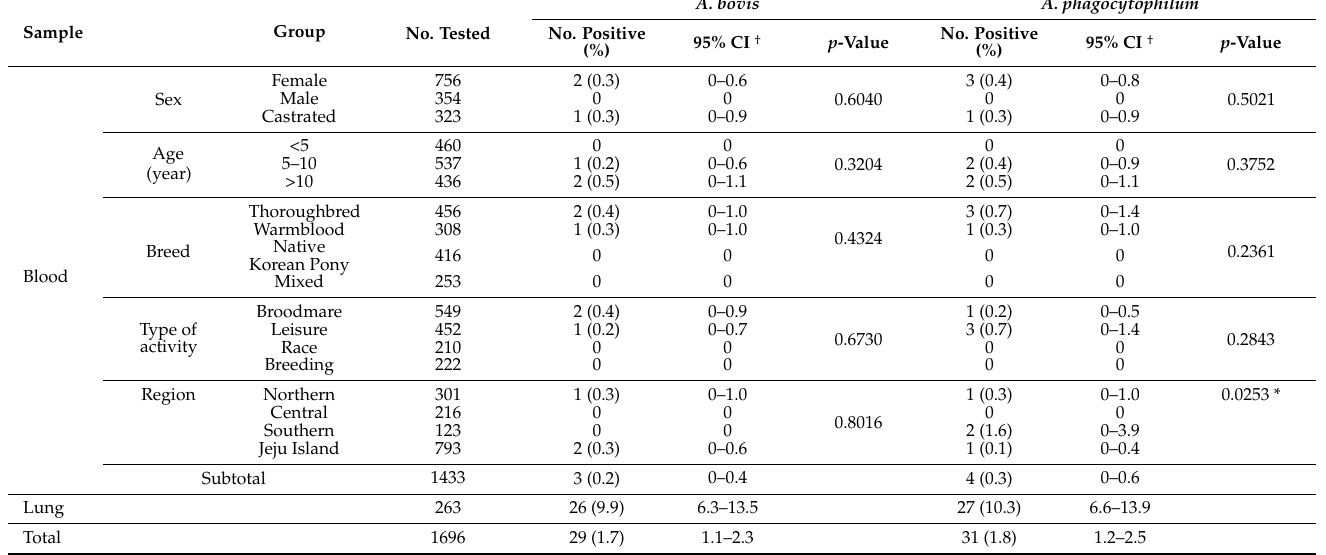
Table 1. Prevalence of Anaplasma bovis and A. phagocytophilum as determined by the analysis of 16S rRNA genes in horse samples from the Republic of Korea between 2017 and